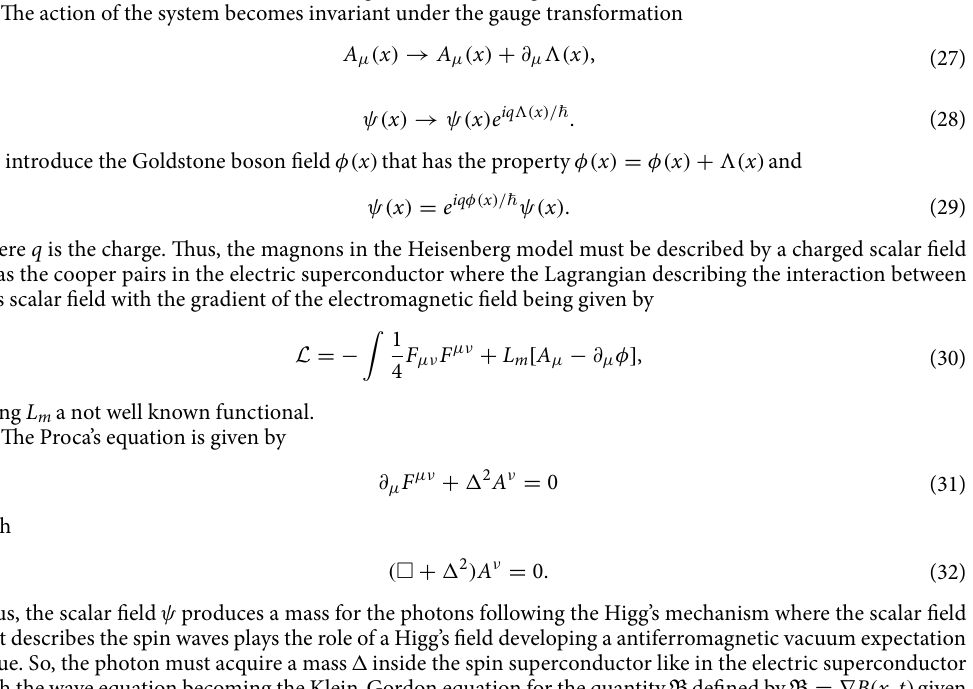
Figure 3. Behavior of the contribution of the interaction between electron with the domain-wall, σ 0.1 J . The very small value of this contribution is due to interaction of only one electron the temperature T = with the ferromagnetic three-dimensional wall domain. In the electric current we have a flow of N electrons by